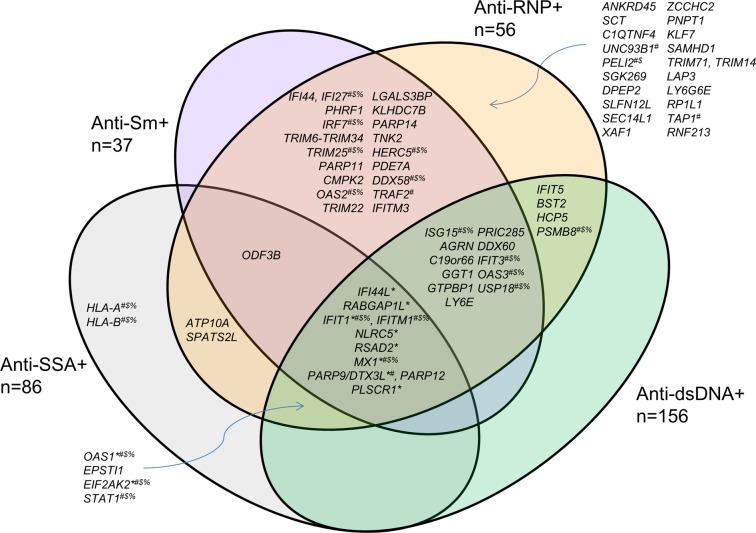
Overlap of genes whose DNA methylation status is significantly associated with at least one SLE-related autoantibody.Results are based on multivariable linear regression analyses using the combined dataset. * Identified in anti-dsDNA discovery/replication analyses; # REACTOME immune system gene; $ REACTOME cytokine signaling gene; % REACTOME interferon signaling gene.